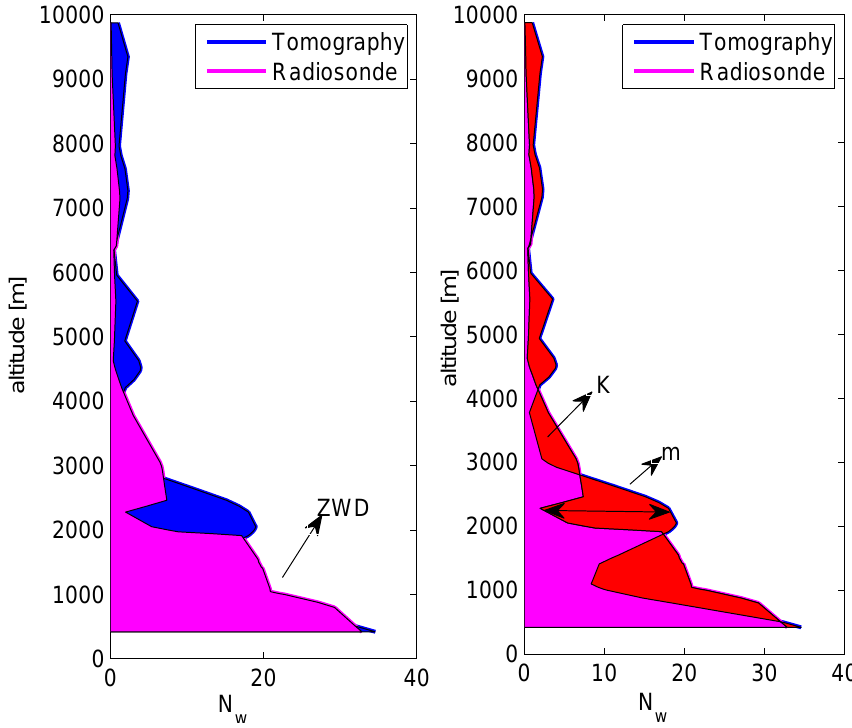
Fig. 9. Example profiles from the station K¨ummersbruck on 3 January 2007, 12:00UTC. Used parameter for the validation. m : maximal absolute difference of N w ; ZWD: zenith wet delay (left panel); D : difference ZWD; K : integral of absolute difference wet refractivity (right panel). Table 3. Criteria for unmatched profiles (left) and well-matched profiles (right) between radiosonde and GPS tomography. ZWD [mm] Poor m or d or k Good m and k ZWD < =